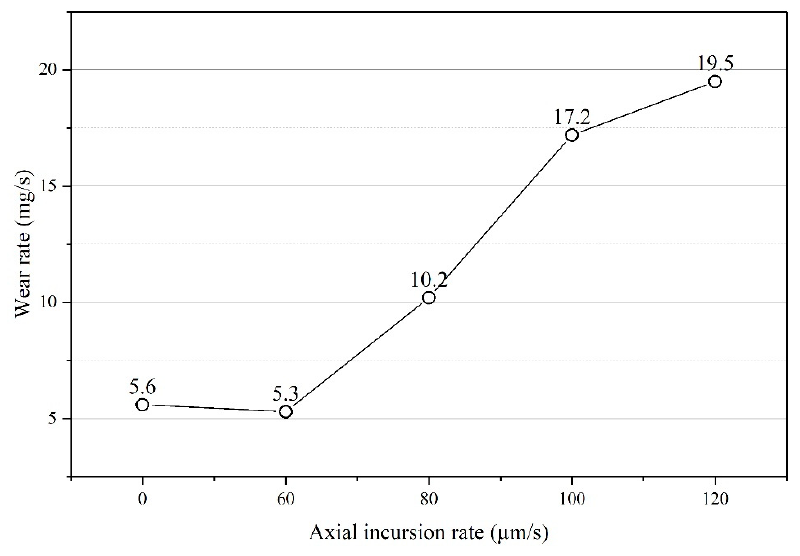
Figure 8. The wear rate of the seal fin at different axial incursion rates.